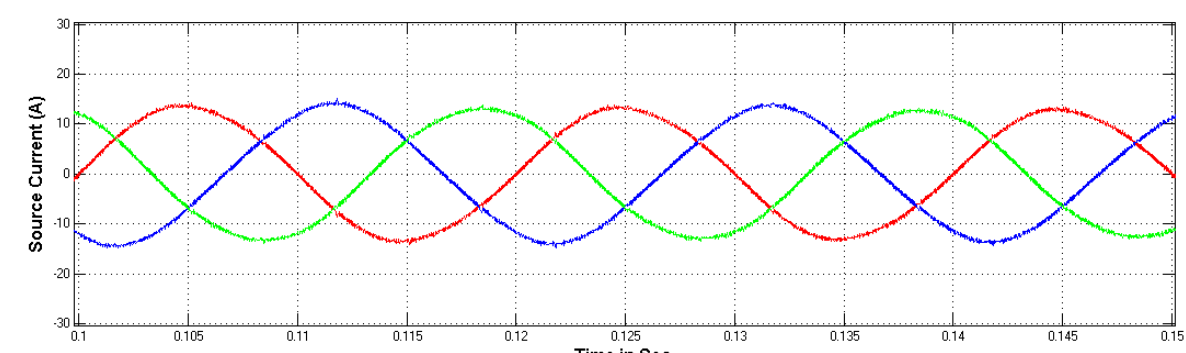
Figure 25. Source Voltage